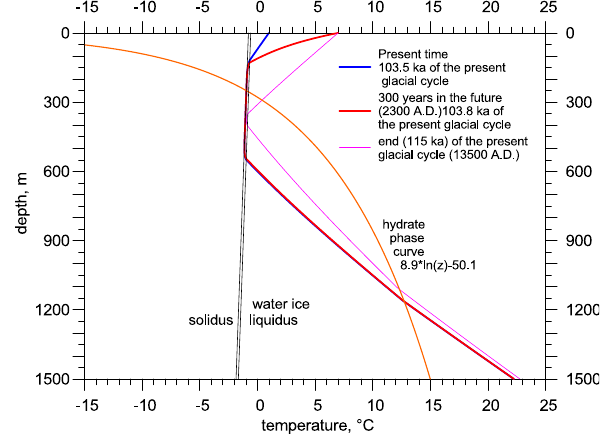
Fig. 13. Tempertaure ( T )-depth ( z ) profiles corresponding to a Fig. 13 . Tempertaure (T)-depth (z) profiles corresponding to a model based on Taylor's surface temperature history affected by both the Holocene marine transgression and the model based on Taylor’s surface temperature history affected by possible future warming due to a doubling of atmospheric CO 2 content. both the Holocene marine transgression and the possible future warming due to a doubling of atmospheric CO 2